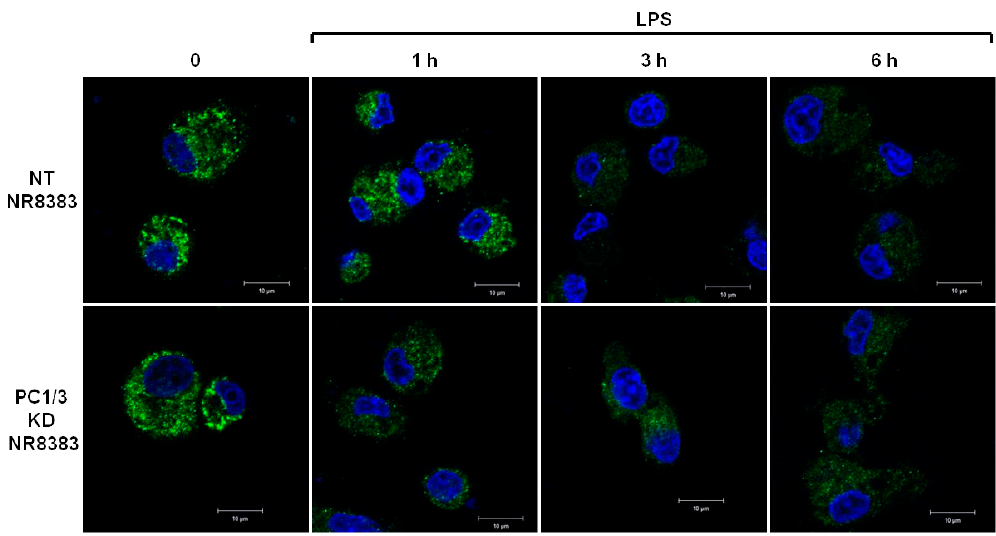
Figure 1. After its internalization, TLR4 is more quickly re-expressed at the plasma membrane of PC1/3 KD macrophages challenged with LPS. NT and PC1/3 KD NR8383 macrophages were treated with 200 ng/mL of LPS for 0, 1, 3, and 6 h. Cells were then fixed and stained with an antibody directed against the extracellular domain of TLR4 (green). To label TLR4 at the cell surface, no permeabilization step was performed. The nuclei were counterstained with Hoechst 33,342 (blue). Confocal microscopy analysis was then performed. Bar = 10 μ m ( n = 3).